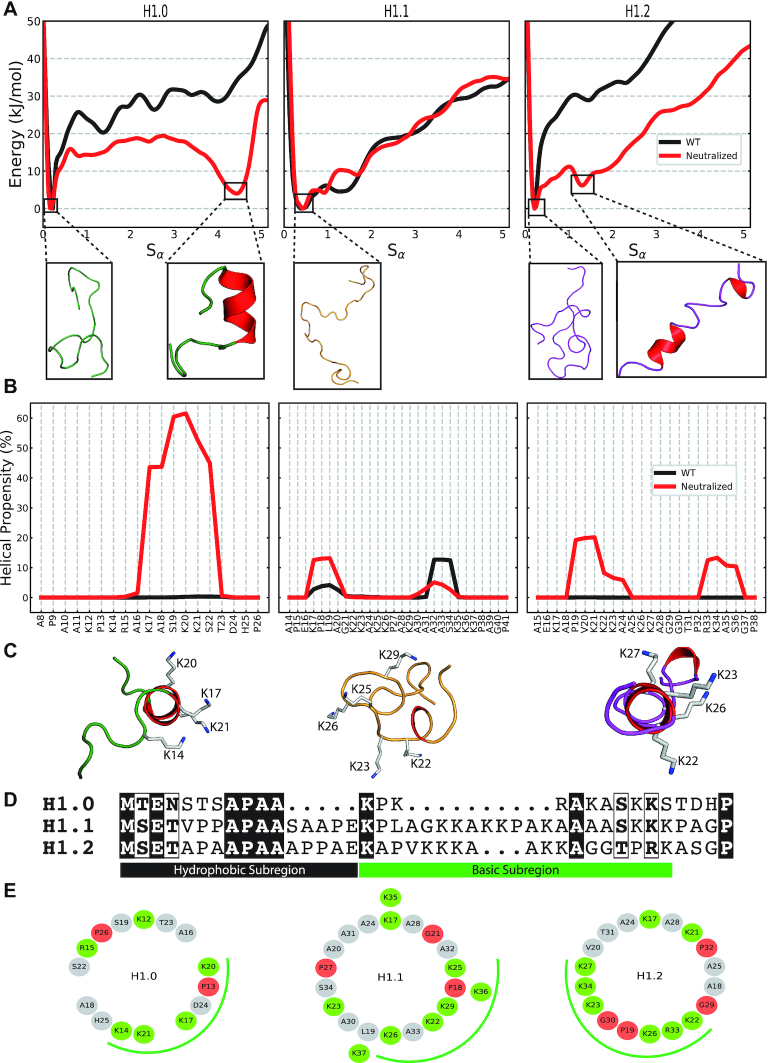
Inducible amphipathic helicities of the H1 NTDs. (A) The one-dimensional free energies along the Sα CV for the WT NTDs (black) and with neutralized Lys sidechains (red). The conformations at each of the free energy minima are illustrated with the α-helical motifs coloured in red. (B) The reweighted per-residue helical content from PTMetaD-WTE simulations of the WT NTDs (black) and with neutralized Lys sidechains (red). (C) Top-down illustrations of the induced NTD conformations from PTMetaD-WTE simulations with neutralized Lys sidechains. The α-helical motifs are coloured red and the residues within the positive ‘face’ are illustrated. (D) Sequence comparison of the of the hH1.0, hH1.1 and hH1.2 linker histone NTDs. (E) Helical wheel projections of the basic subregions of the three H1 NTDs. Basic Arg/Lys residues are in green while the helix-breaking Pro/Gly residues are in red. The basic ‘face’ of each subtype is illustrated with a green curve.